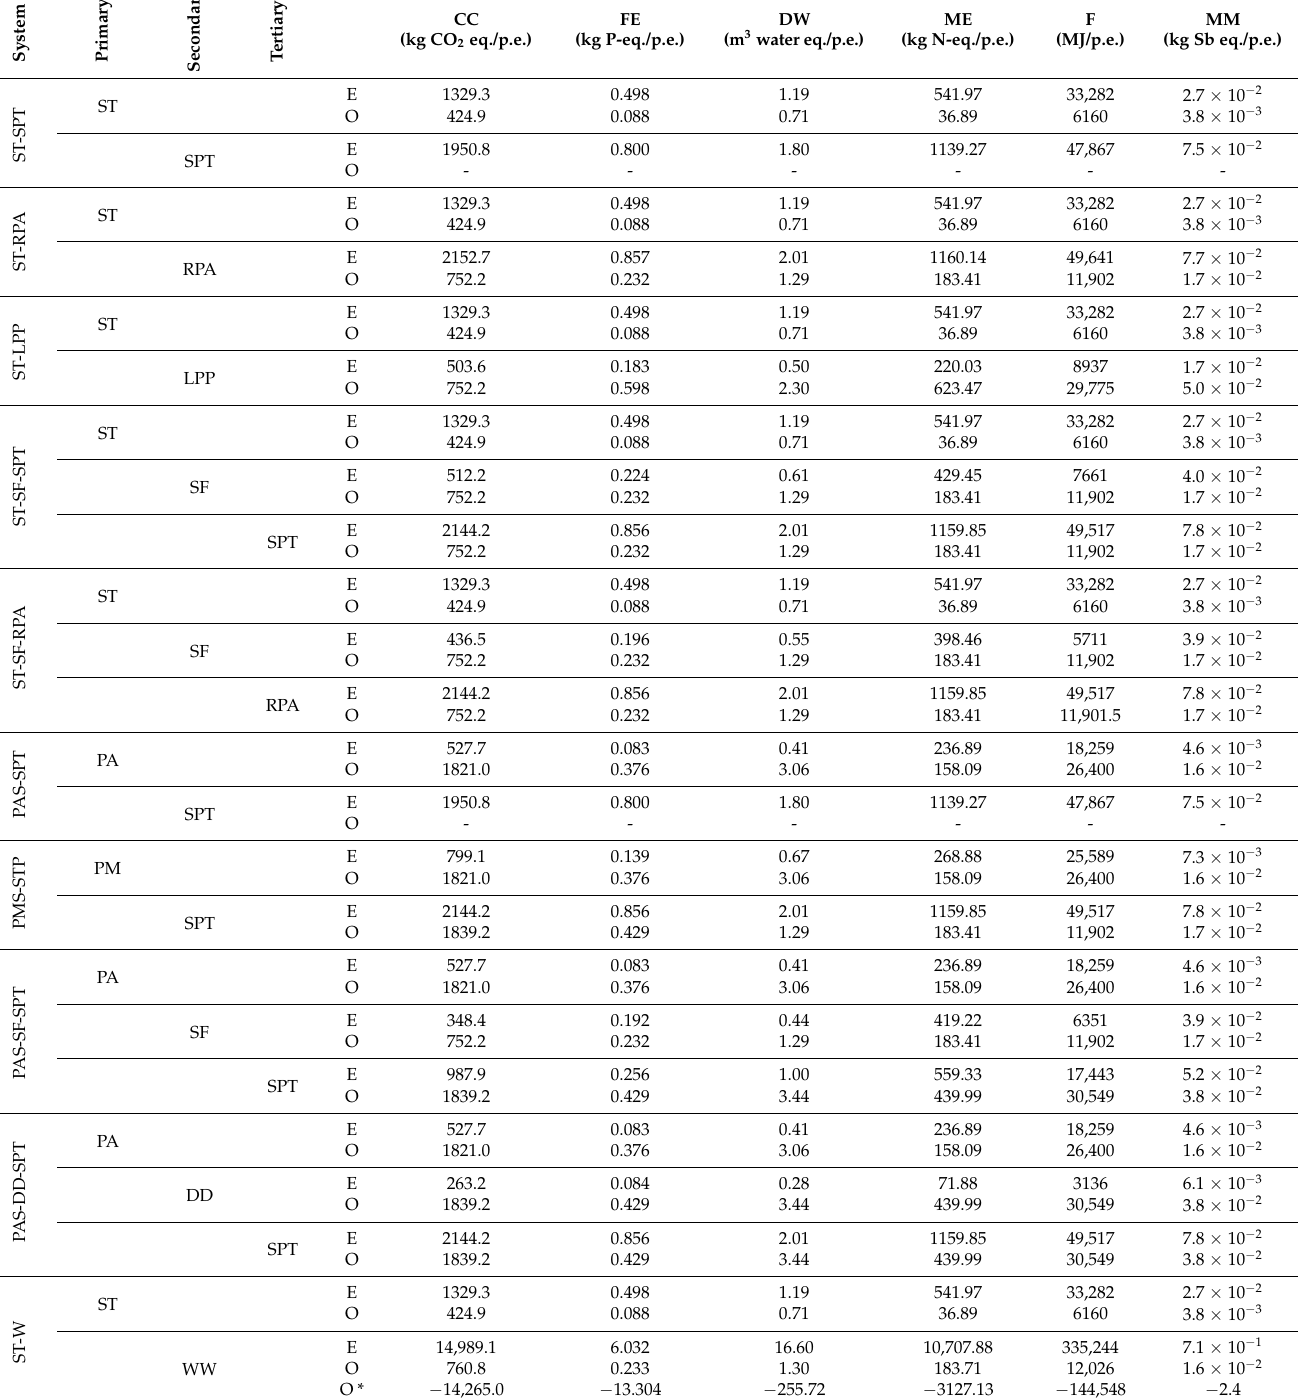
Table A3. A breakdown of the embodied (E), operational (O) and offset (O*) environmental burdens of each primary, secondary and tertiary treatment processes within the 10 on-site